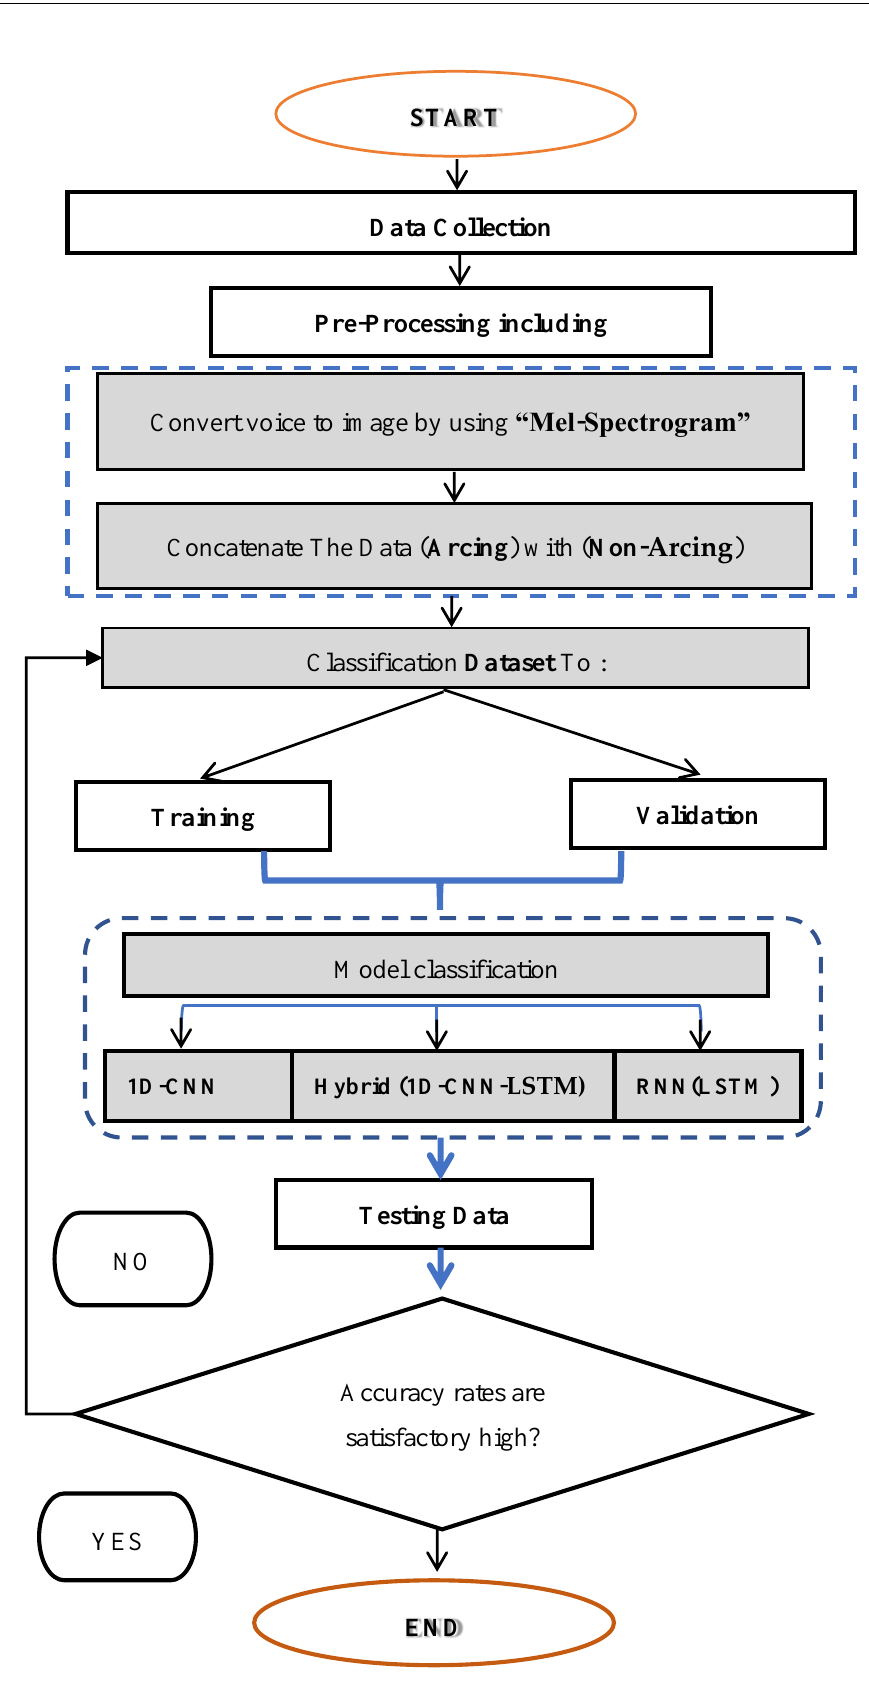
Figure 1. Diagram Illustrating the Overall Process of The Research Techniques.